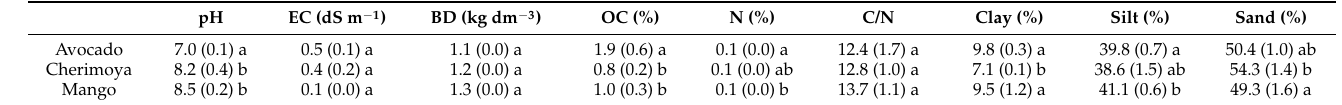
Figure 1. Location of the sampling area, aerial image of the farm, placement of the different bagged pruning waste under the avocado, chirimoya, and mango trees, and detail of the bagged pruning waste. The experimental farm is located in an area with slopes that vary between 30 and 60%. The crops are located on flat terraces. The climate is subtropical Mediterranean, with an average temperature during the study period of 21.3 ◦ C (maximum average monthly temperature of 30.5 ◦ C and minimum of 6.9 ◦ C), average relative humidity of 77%, accumulated rainfall of 5323.6 mm, and accumulated evapotranspiration (ETo) of 7322.2 mm. The avocado, cherimoya, and mango crops have a planting frame of 8, 6, and 3 m and an age of 29, 21, and 14 years, respectively. Data related to the soil properties analyzed at the beginning of the experiment appear in Table 1. Table 1. Mean values of the soil properties analyzed at the beginning of the experiment below the avocado, cherimoya, and mango trees.